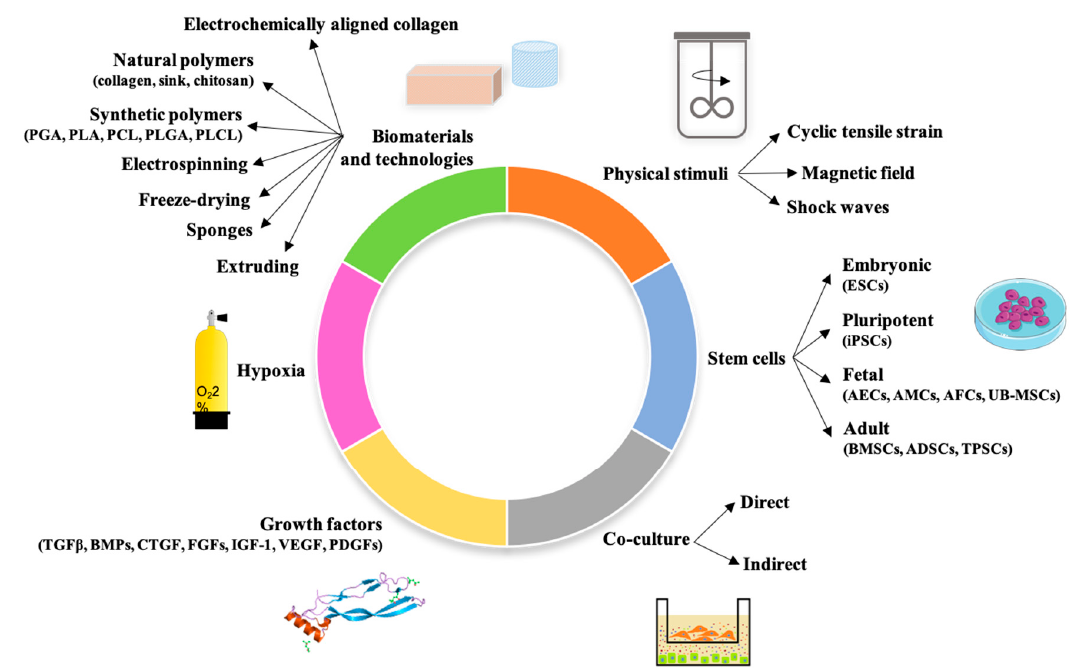
Figure 1. In vitro strategies for tendon tissue engineering. Tendon tissue engineering refers to a multidisciplinary field that aims at the inducement of tissue repair or regeneration. Therefore, it involves the combination of several key factors, such as cells, scaffolds, biochemical and mechanical inputs to produce a functional tendon-like construct. Abbreviations. PGA: polyglycolic acids; PLA: polylactic acids, PCL: polycaprolactones; PLGA: poly(lactic-co-glycolic) acids; PLCL: poly (lactil-co-captolactone) acids; ESCs: embryonic stem cells; iPSCs: induced pluripotent stem cells; AECs: amniotic epithelial stem cells; AMCs: amniotic mesenchymal stem cells; AFCs: amniotic fluid stem cells; UB-MSCs: umbilical cord mesenchymal stem cells; BMSCs: bone marrow mesenchymal stem cells; ADSCs: adipose derived mesenchymal stem cells; TPSCs: tendon progenitors stem cells; TGF β : transforming growth factor beta; BMPs: bone morphogenetic proteins; CTGF: connective tissue growth factor; FGFs: fibroblastic growth factors; IGF-1: VEGF: vascular endothelial growth factor; PDGFs: platelet-derived growth factor.